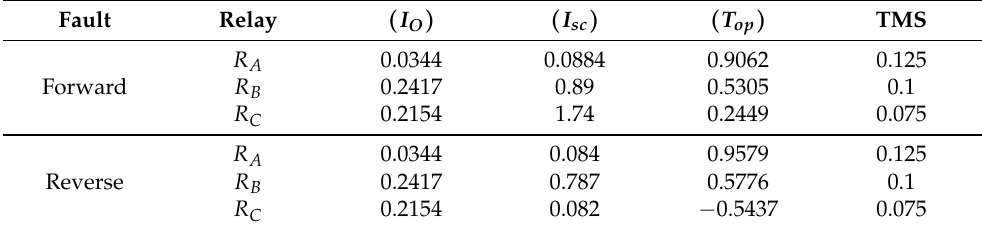
Figure 13. Magnitude of impedance angle as a function of time and phase angle jump during different fault conditions, ( a ) positive impedance angle for forward fault, ( b ) negative impedance angle for reverse fault, ( c ) ascending impedance angle and retarding phase jump exhibit forward current direction and descending impedance angle and progressing phase angle jump indicate reverse current flow. Table 1. Operating characteristics of relays for forward and reverse